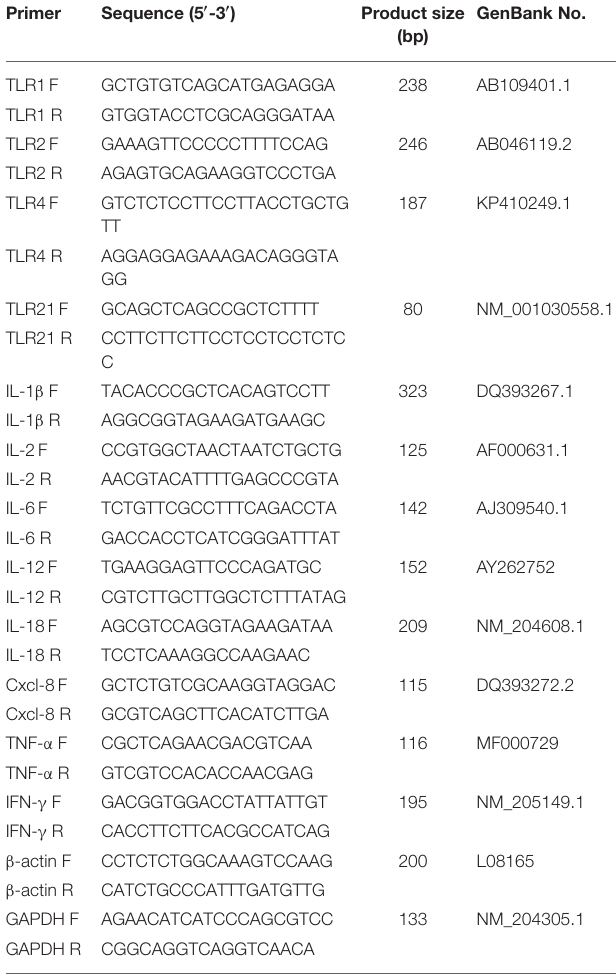
TABLE 1 | Primers used in the